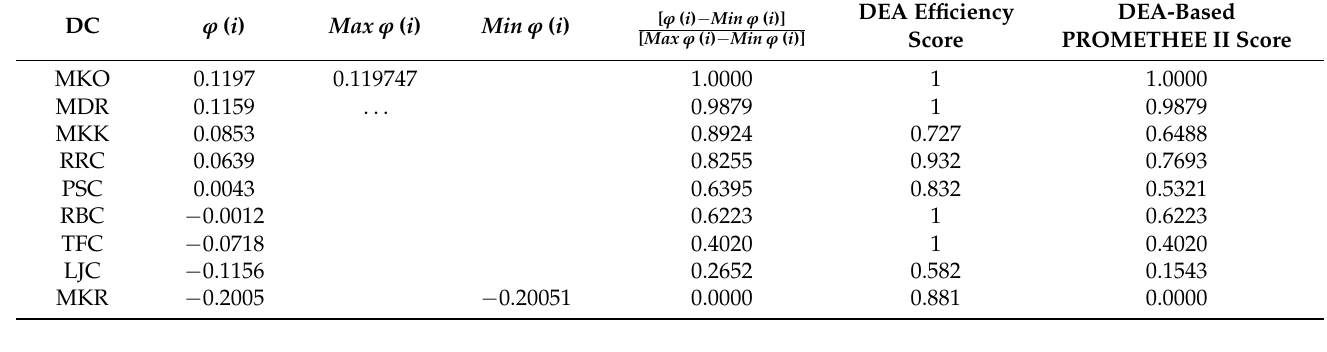
Figure 1. DCs ranking comparison with respect to PROMETHEE II and DEA.